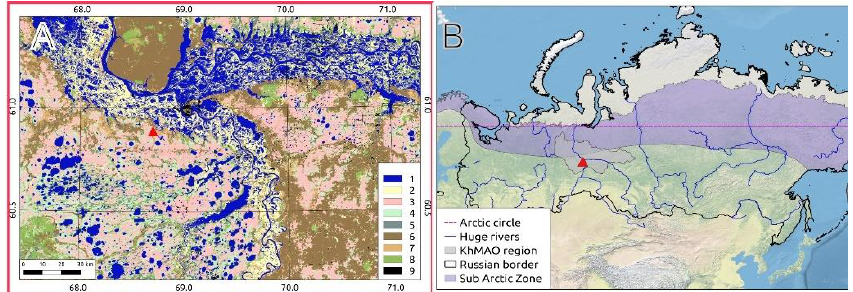
Figure 1. Map of the study region. Location of the Mukhrino field station. ( A ): On the local